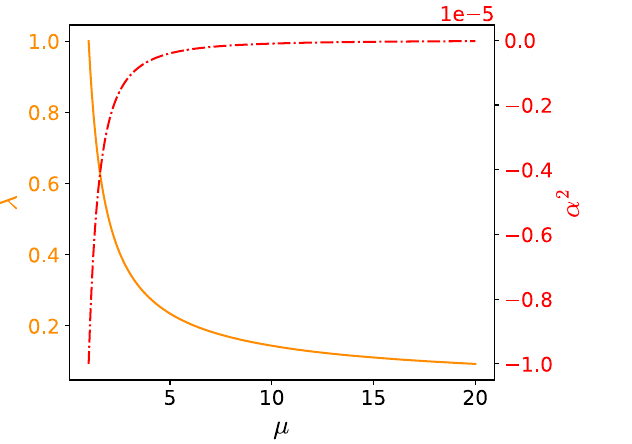
Fig. 2 Numerical solutions for the running of the λ (continuous and orange curve) and α 2 (dotted-dashed and red curve) parameter. The initial conditions correspond to v 2 = at the initial energy μ 0 = 1 (all the quantities are measured in the corresponding powers of eV)